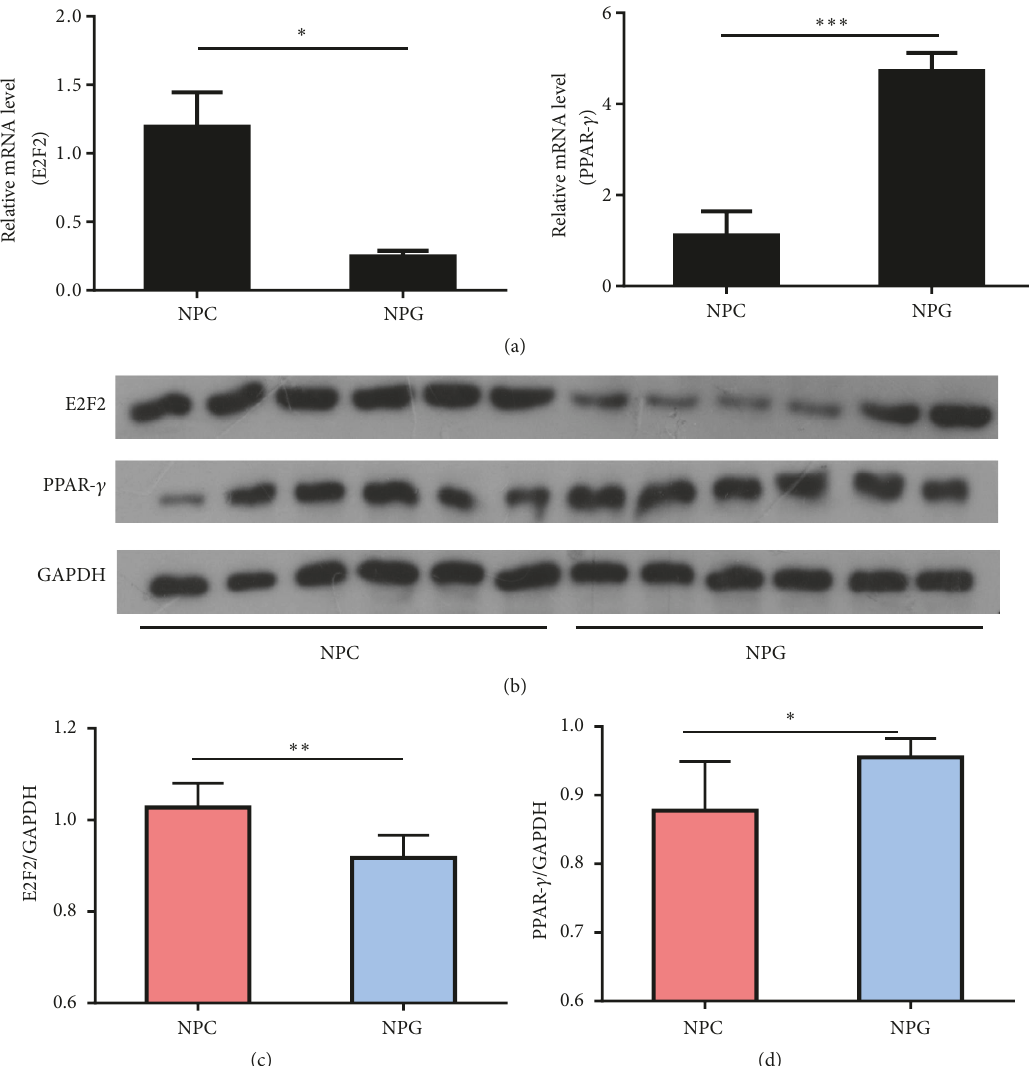
Figure 2: E2F2 and PPAR- 𝛾 protein expression in nonkeratinizing nasopharyngeal carcinoma (NPC) and nasopharyngitis (NPG) tissue lysates . (a, b) RT-PCR and Western blotting were performed to detect the expression of E2F2, PPAR- 𝛾 , and GAPDH in lysates of nonkeratinizing NPC and NPG tissues. (c, d) Quantitative analyses of the E2F2 and PPAR- 𝛾 expression levels in nonkeratinizing NPC and NPG tissues. Data are expressed as means ± standard deviations. ∗ P < 0.05; ∗∗ P <